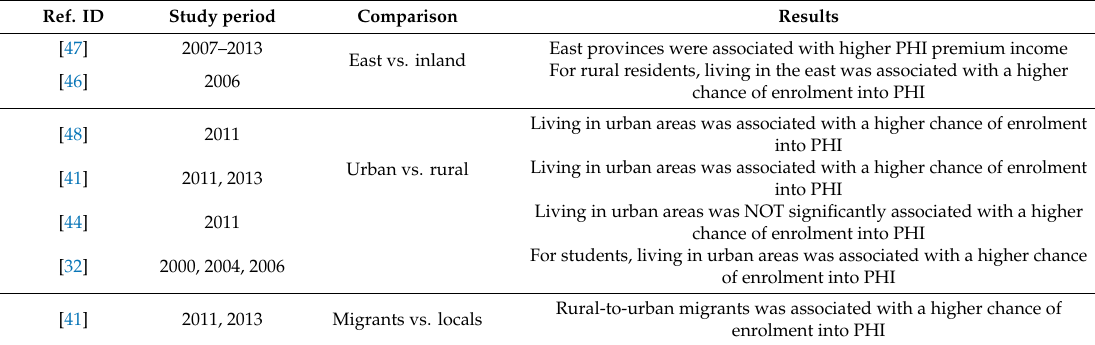
Table 2. Comparison of PHI coverage spatially or between di ff erent migration status 1 . Ref.